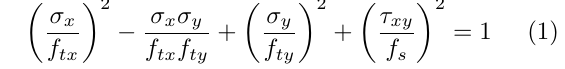
Figure 1. Compact tension (CT) test set up: W = 46 mm, a = 20 mm and thickness is 11 mm.